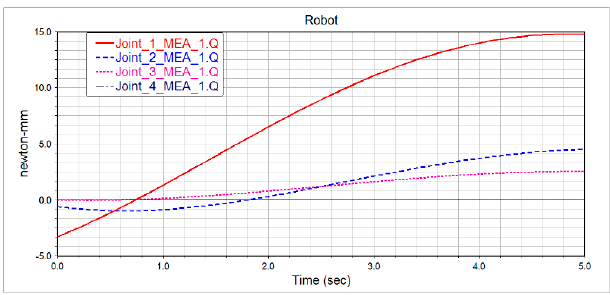
Figure 9. Torque transformation curves of each joint .